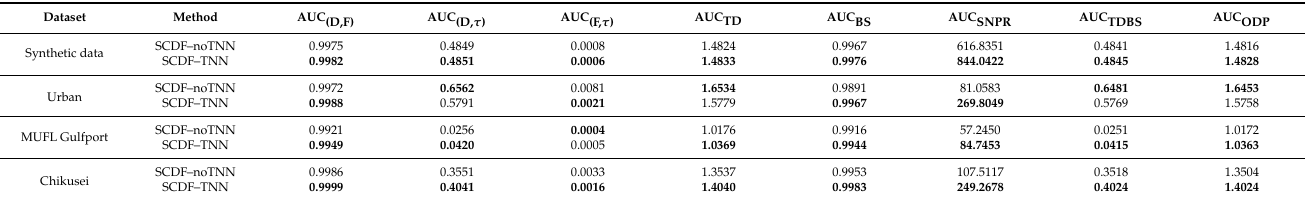
Figure 17. The detection results of the SCDF method with TNN and the SCDF method without TNN on each dataset: ( a ) SCDF–noTNN; ( b ) SCDF–TNN. Table 7. Comparison of AUC performance of the SCDF method with TNN and the SCDF method without TNN on each dataset.